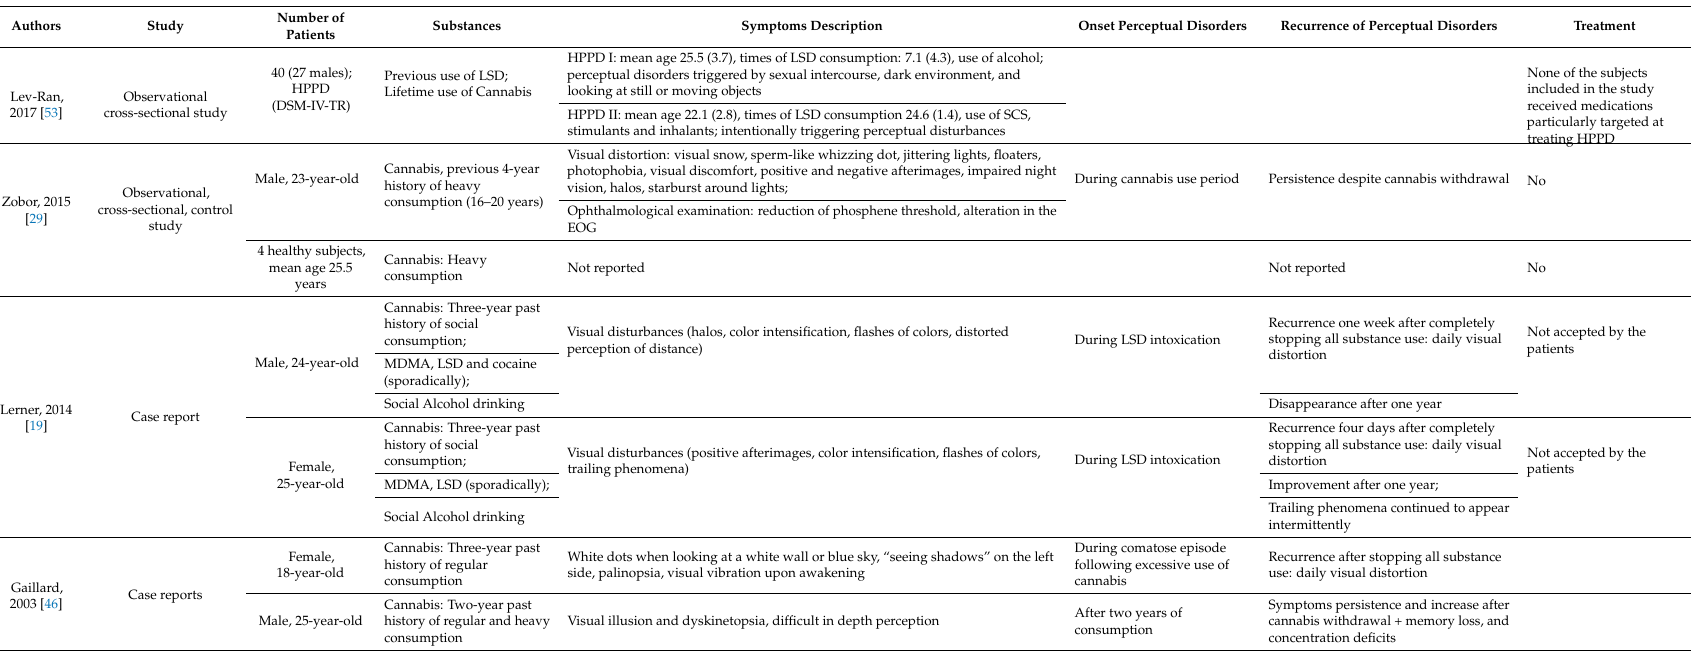
Table 4. Observational studies and case reports evaluating clinical